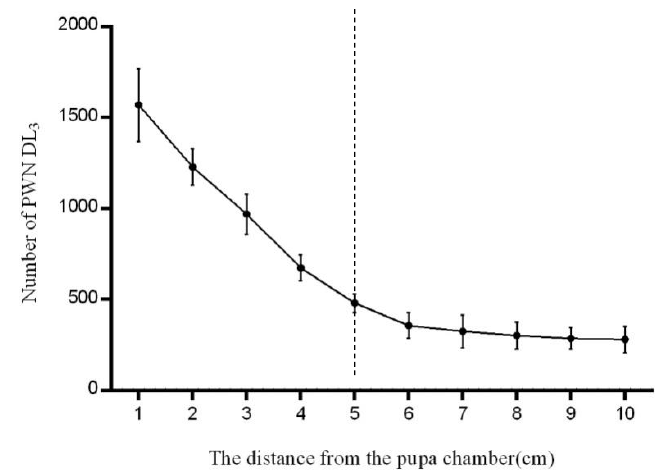
Figure 3. Number of third ‐ stage dispersal juveniles of pinewood nematodes in blocks at different distances near the pupal chamber of Monochamus saltuarius Gebler. PWN DL 3 : third ‐ stage dispersal juveniles of pinewood